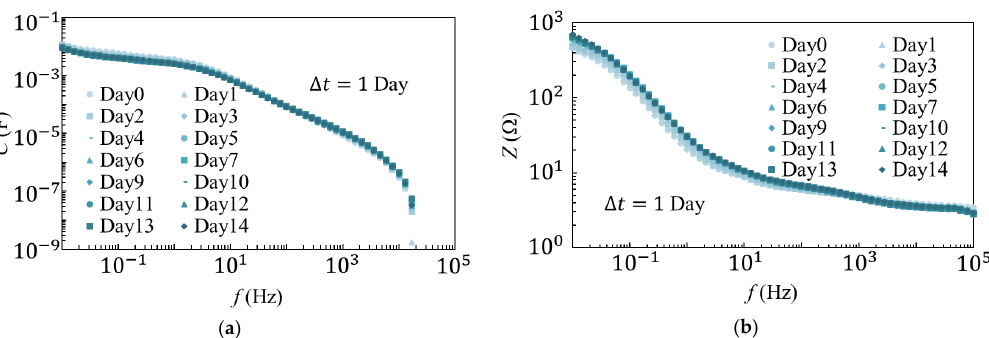
Figure 9. Measurement results of ( a ) C and ( b ) Z in the 25 °C degradation tests with discharge.